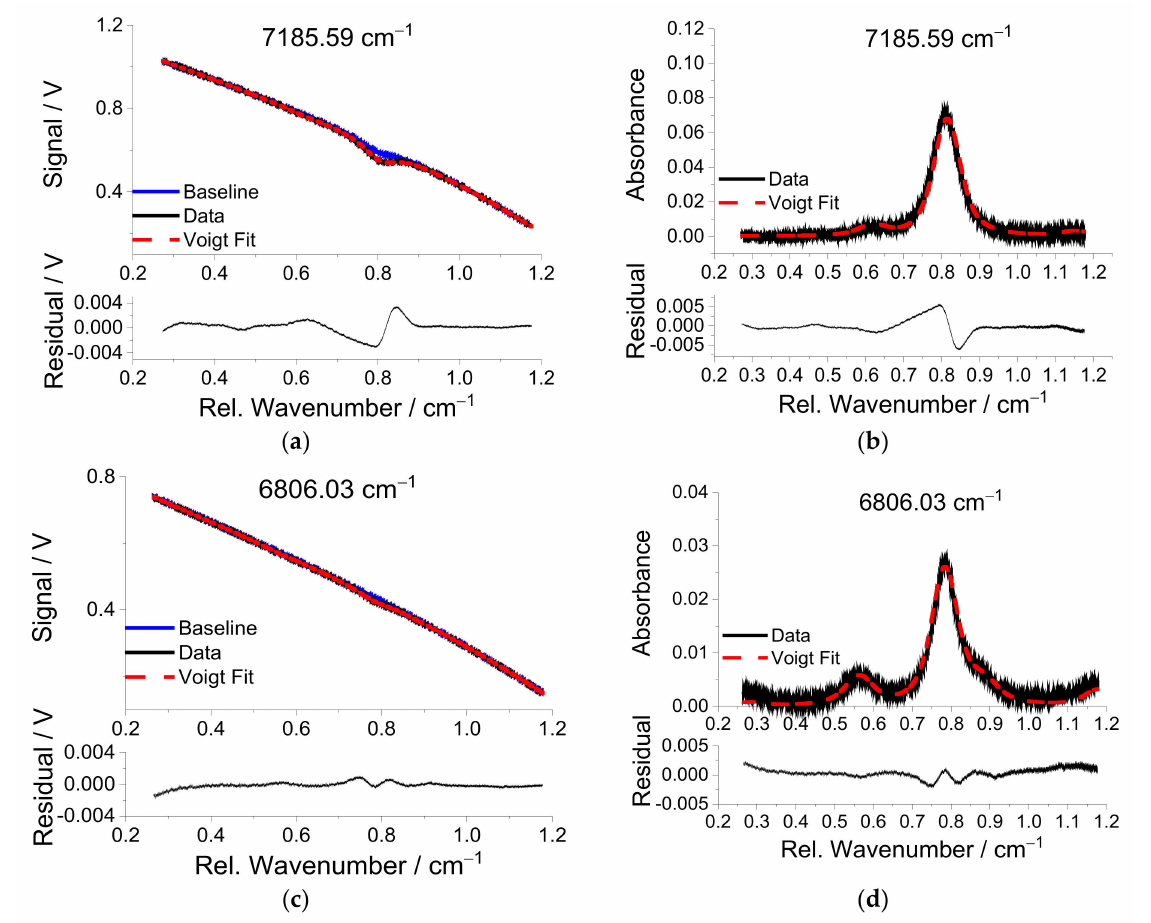
Figure 8. Water vapor transmitted signal (black lines in ( a , c )) and calculated absorbance (black lines in ( b , d )) over relative wavenumber at the H 2 O center wavelengths 7185.59 and 6806.03 cm − 1 , respectively, for the premixed flame no. 17 (Table 2). The separately measured baseline (blue lines in ( a , c )) and fitted Voigt functions (dashed red lines) are also shown. The residuals shown in the lower section of each figure are between original data and fitted line